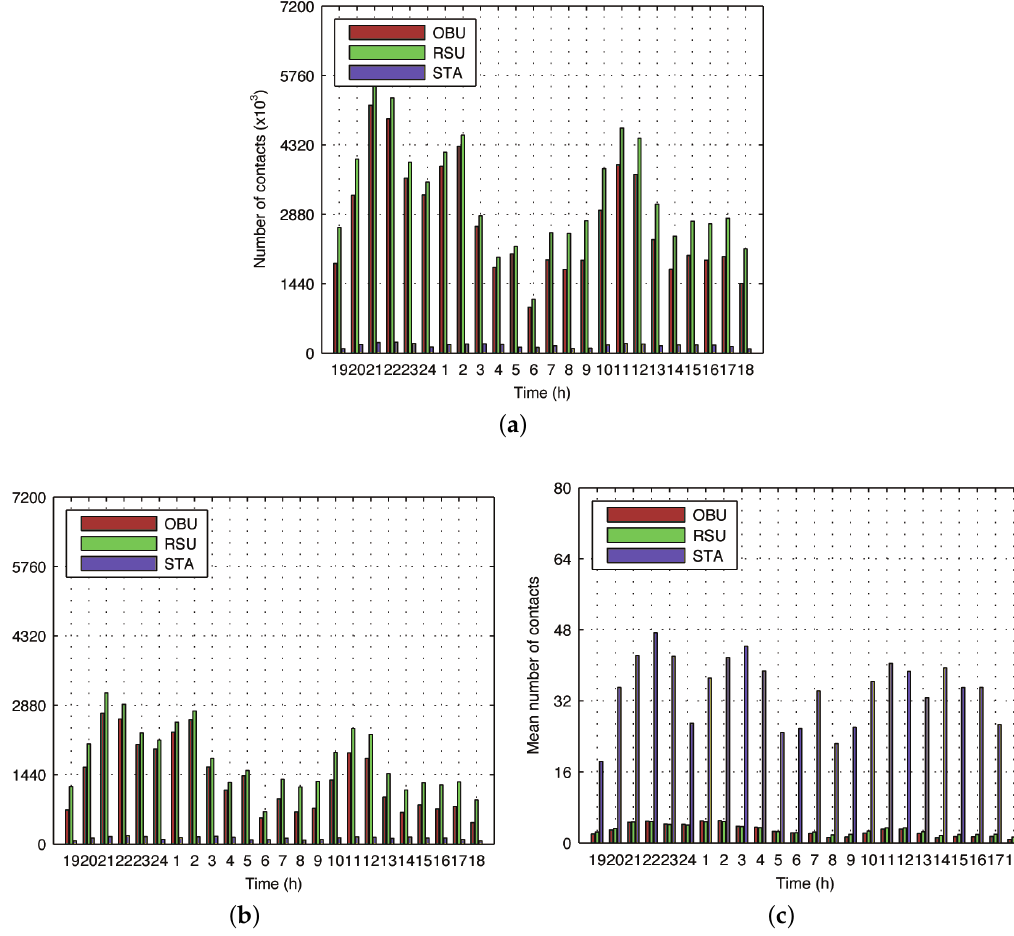
Figure 10. Contacts per hour. ( a ) Number of all type of contacts per hour; ( b ) Number of valid contacts per hour; ( c ) Normalized number of valid contacts per